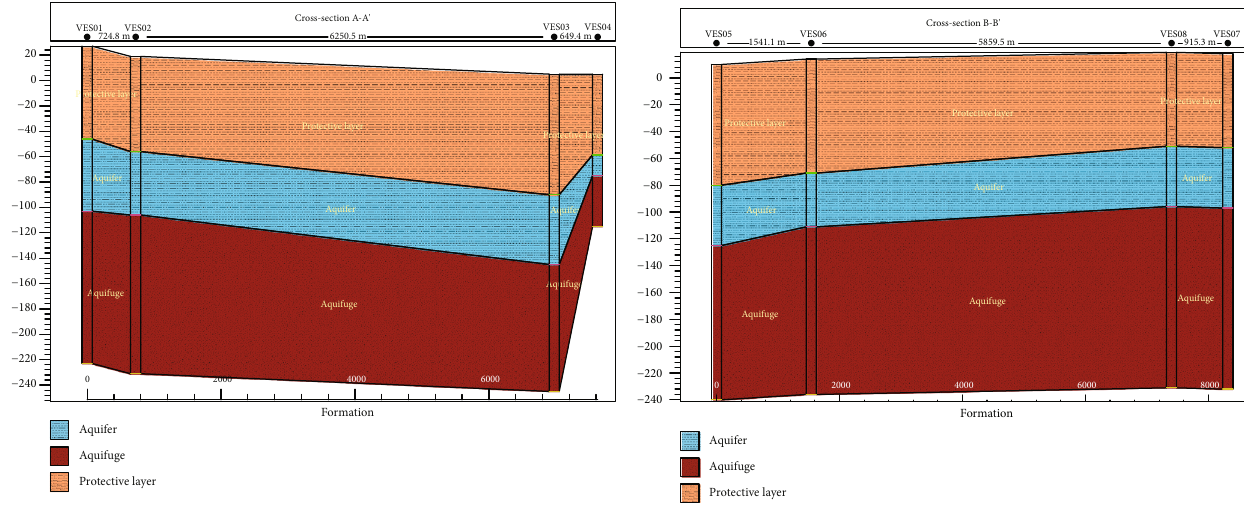
Figure 8: Hydrogeological